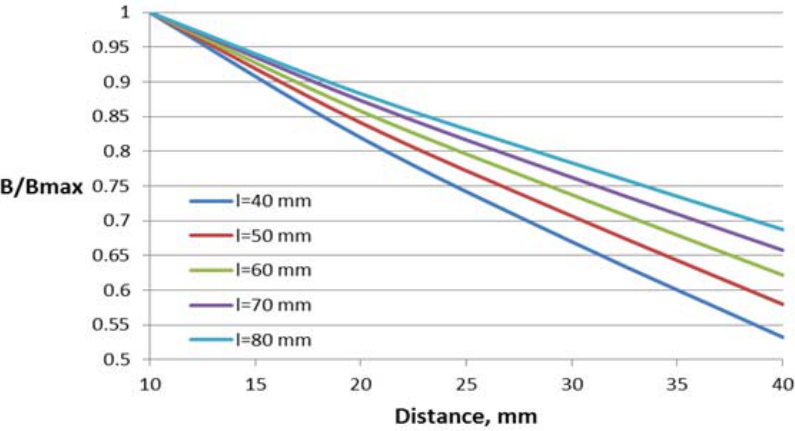
Figure 7. Dependence of the flux density on the distance to the conductor for the concentrator with one gap and different window lengths l .